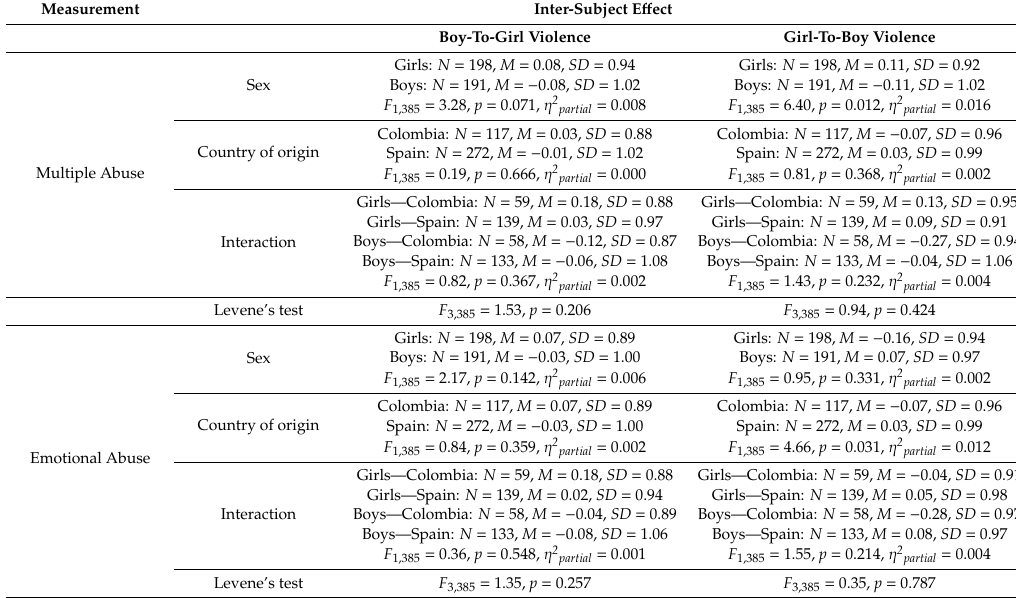
Table 6. ANOVA results for the Questionnaire of Perception of Inter-Partner Violence from boy-to-girl and girl-to-boy.